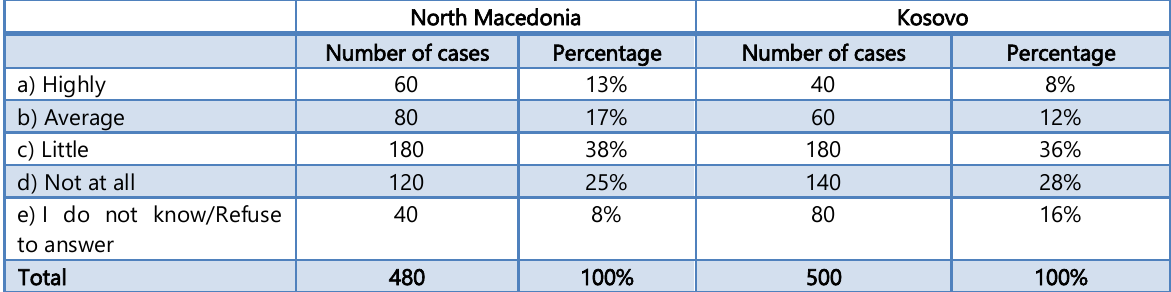
Table 2: How Much are your Opinions Taken Into Account by the Municipal